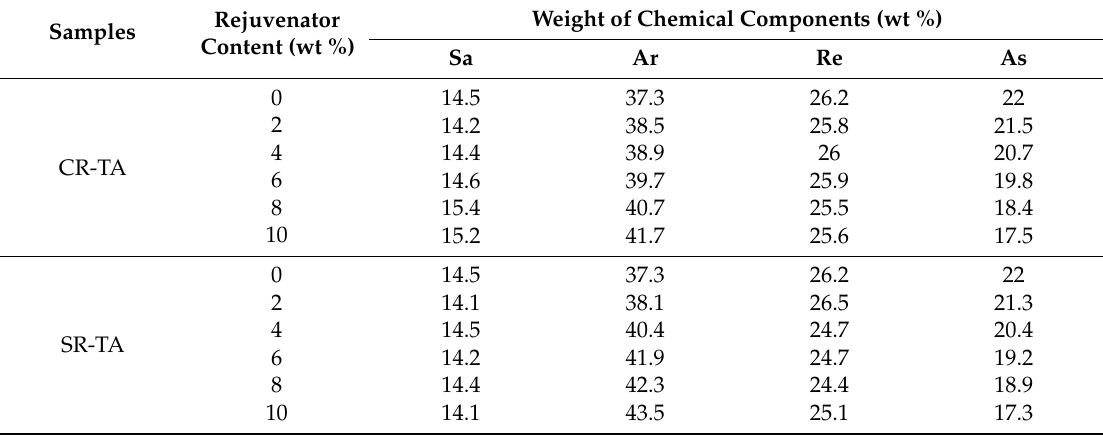
Table 4. Chemical components of regenerated TA containing CR and SR.